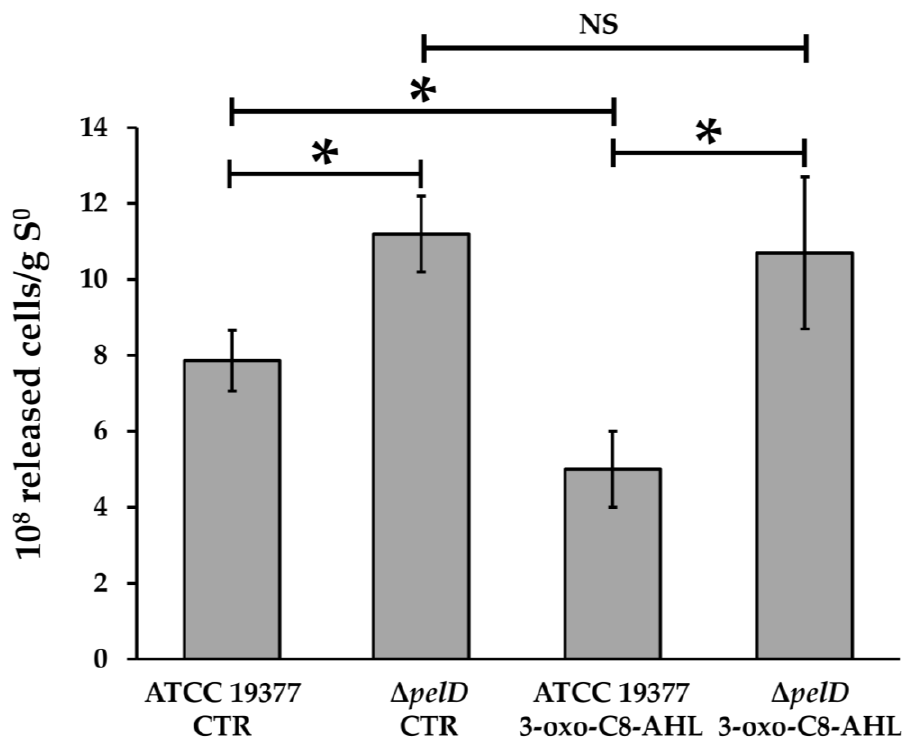
Figure 2. The presence of PEL exopolysaccharide offers a stronger embedment into the biofilm matrix for At. thiooxidans cells. Inoculated S°-coupons extracted from 5-days growth cultures were treated with 0.05% Triton X-100 and vortexed during 10 min. Number of cells released from the wild type and ∆ pelD null-mutant biofilms subjected to mechanical stress was determined with a Petroff-Hausser counting chamber and normalized against mass of sulfur. Significant differences calculated by a one-way ANOVA test ( p < 0.05) are noted (*). CTR, DMSO 0.01% without AHL. NS, No significant difference.